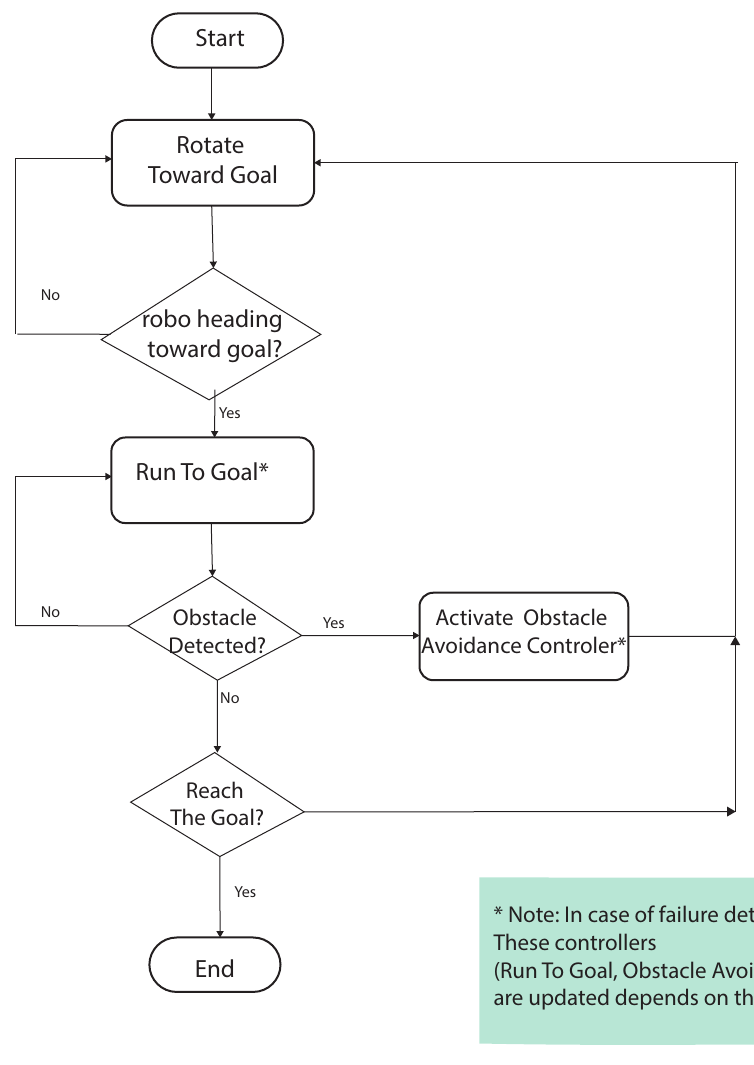
Figure 3. Flow chart for the path planning